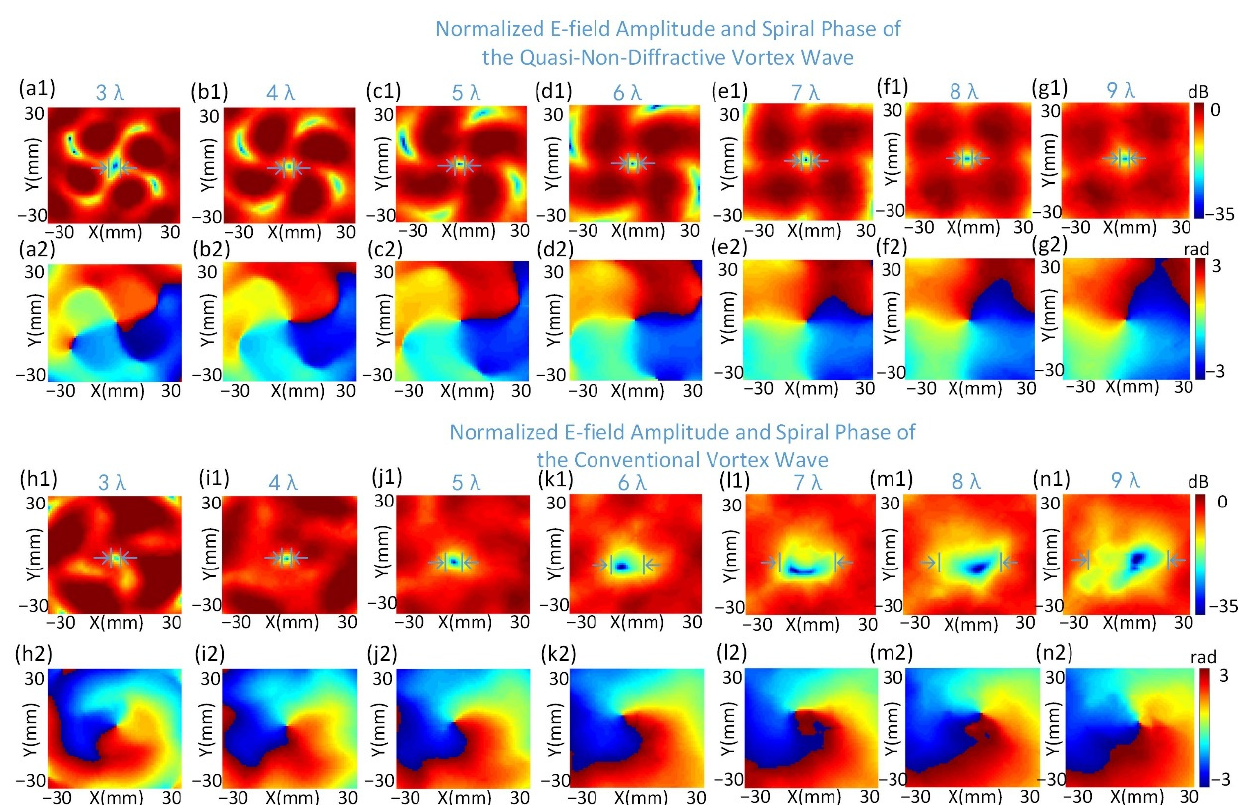
Figure 6. Comparison between the quasi-non-diffractive and conventional vortex waves. The ( a1 – g1 ) normalized E-field amplitude and ( a2 – g2 ) spiral phase of the quasi-non-diffractive vortex wave. The ( h1 – n1 ) normalized E-field amplitude and ( h2 – n2 ) spiral phase of the conventional vortex wave.